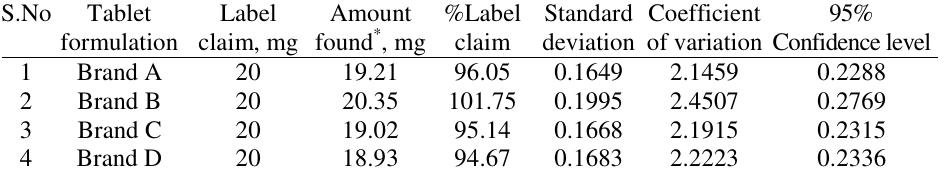
Table 2. Analysis of levoceterizine dihydrochloride in tablets